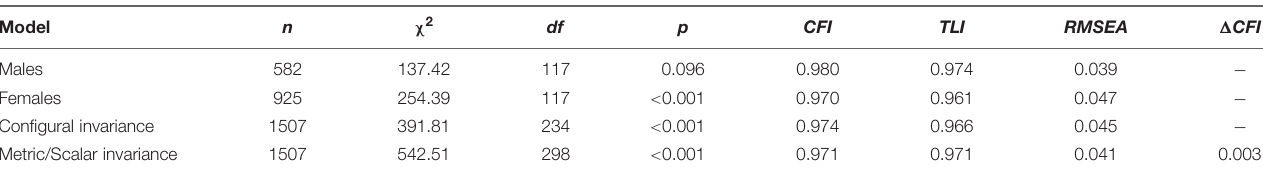
TABLE 4 | Fit statistics for the bifactor model tested for invariance across